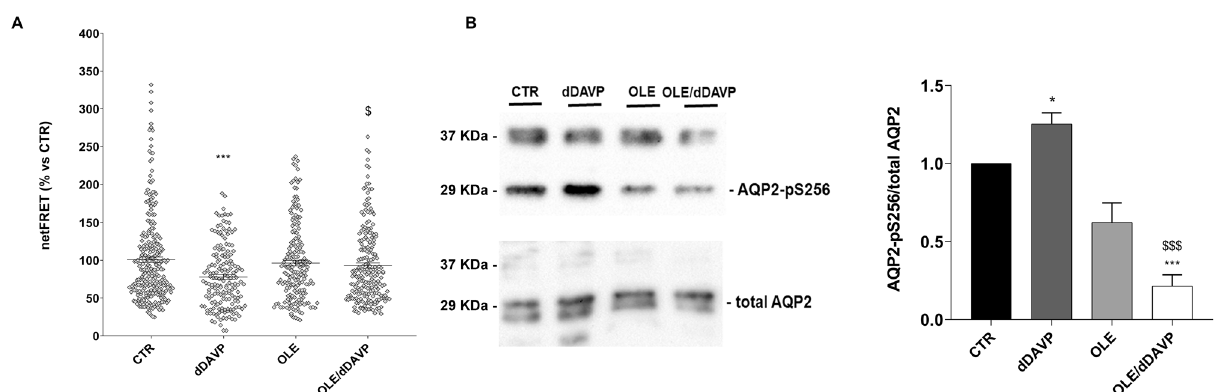
Figure 2. Effects of OLE on AQP2 phosphorylation and cAMP production in MCD4 cells. ( A ) Evaluation of cAMP production by FRET experiments in MCD4 cells transiently transfected with H96 as described in the “Materials and methods” section. Histogram reports netFRET measured in cells under basal conditions, treated with dDAVP (100 nM for 30 min), OLE (0.1 mg/ml O/N), or co-treated with OLE and dDAVP. The treatment with dDAVP displayed a significantly higher cAMP production depicted as a reduced netFRET signal. Data are shown as single values in a scatter plot reporting means ± S.E.M (***p < 0.001 vs CTR; $p < 0.05 vs dDAVP). ( B ) Lysates from MCD4 cells were subjected to immunoblotting using Abs against AQP2-pS256 and totalAQP2. Densitometric analysis of AQP2-pS256 bands normalized to total AQP2 bands (total AQP2) is reported in the histogram. Data are expressed as means ± S.E.M (*p < 0.05 or ***p < 0.001 vs CTR; $$$p < 0.001 vs selective CaSR inhibitor NPS2143 (10 µM). Statistical analysis of the fluorescence responses (Fig. 4B) revealed that incubation with OLE increased cytosolic calcium by 97.06 ± 6.93% (vs ATP 100.00 ± 2.28%). Pretreatment with NPS2143 reduced the OLE induced intracellular calcium increase (OLE/NPS2143 = 18.87 ± 2.17%, n = 59 cells vs OLE = 97.06 ± 6.93%, n = 50 cells; p < 0.001). To deeper investigate whether the effect of OLE on AVP- dependent water reabsorption occurred through the activation of the CaSR signaling, functional studies were performed as previously shown (Fig. 1B). Interestingly, treatment with NPS2143 abolished the inhibitory effect of OLE on AVP-regulated osmotic water permeability (Fig. 5; OLE/dDAVP/NPS2143 = 190.4 ± 7.15%, n = 191